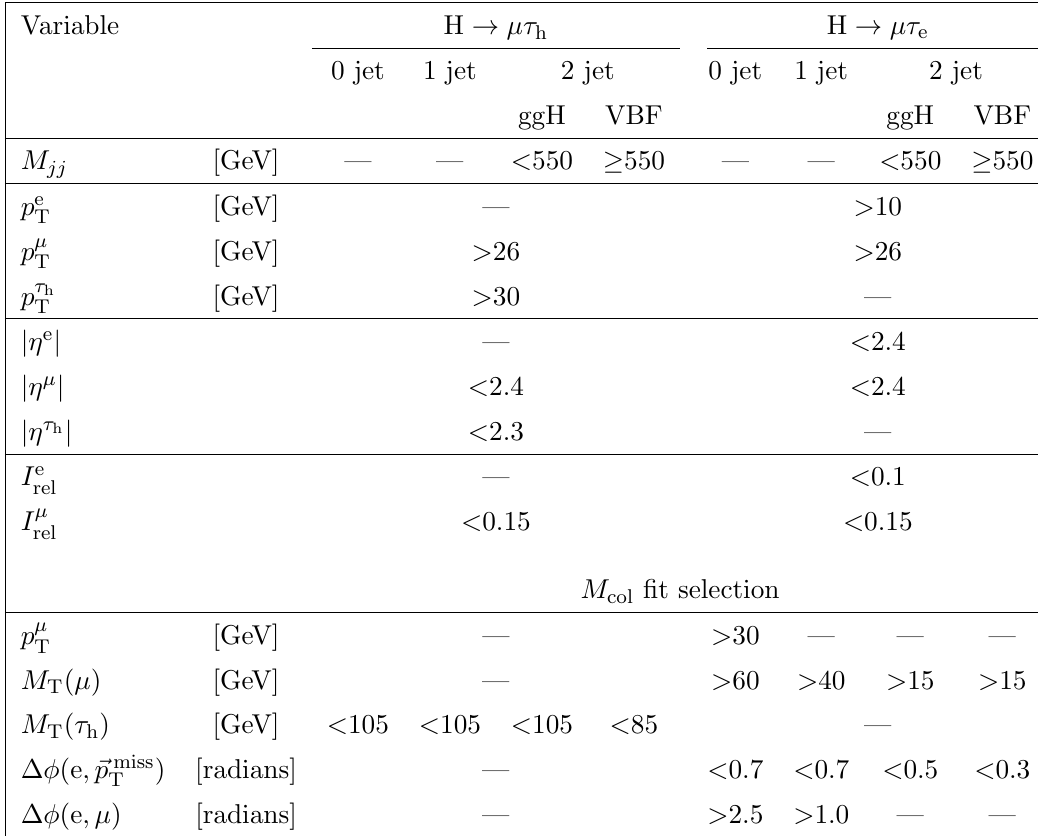
Table 1 . Event selection criteria for the kinematic variables for the H ! (cid:22)(cid:28) channels. M , p miss col